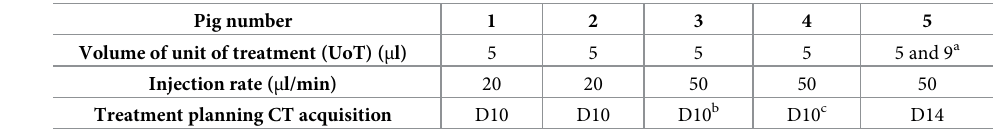
Table 1. Different injection parameters for each